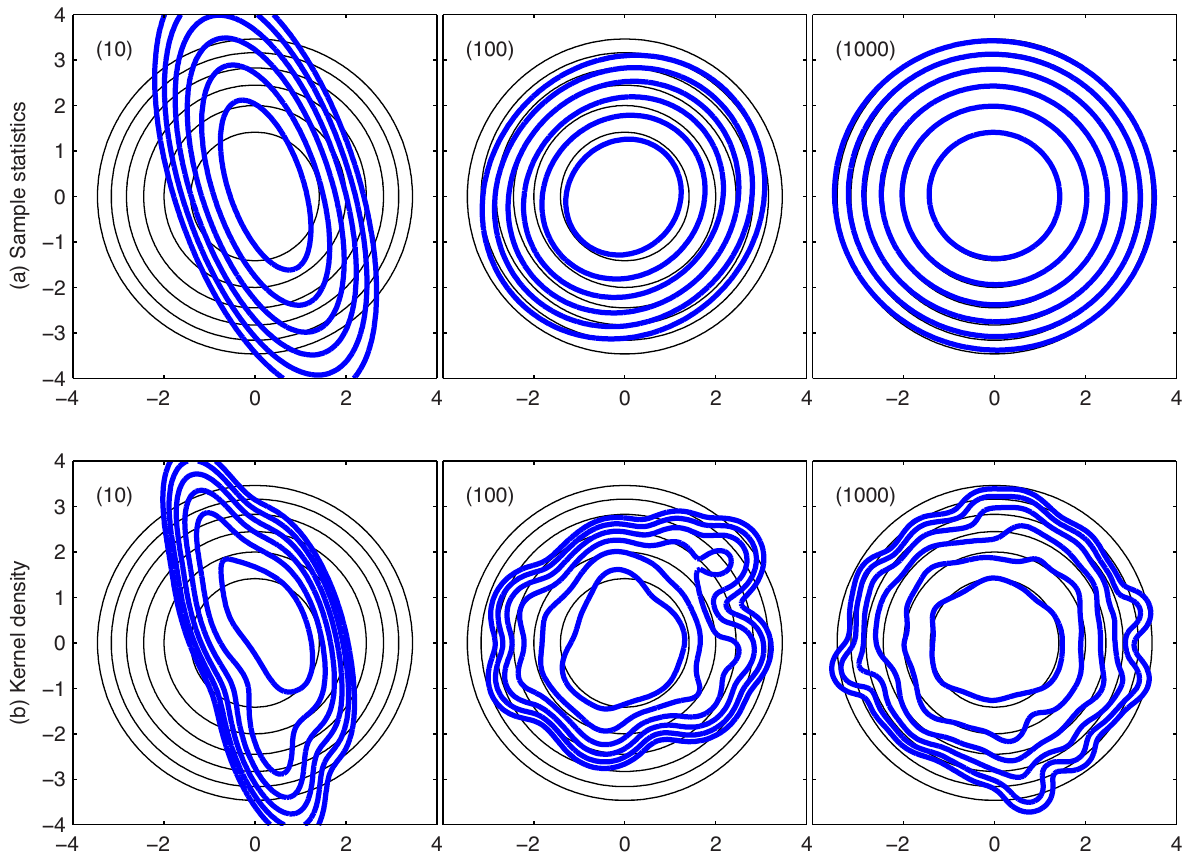
Fig. 1. Continuous estimates of the density of a two-dimensional standard normal random variable. Contours are plotted at equal intervals of the logarithm of the (thin circles) true density and (thick curves) estimated densities. The estimates are the (a) Gaussian with sample mean and covariance and (b) kernel density estimate from the same samples. The number in parentheses is the sample size. The kernel density estimates are computed using the optimal bandwidth and have the same first two moments as the samples (Silverman,